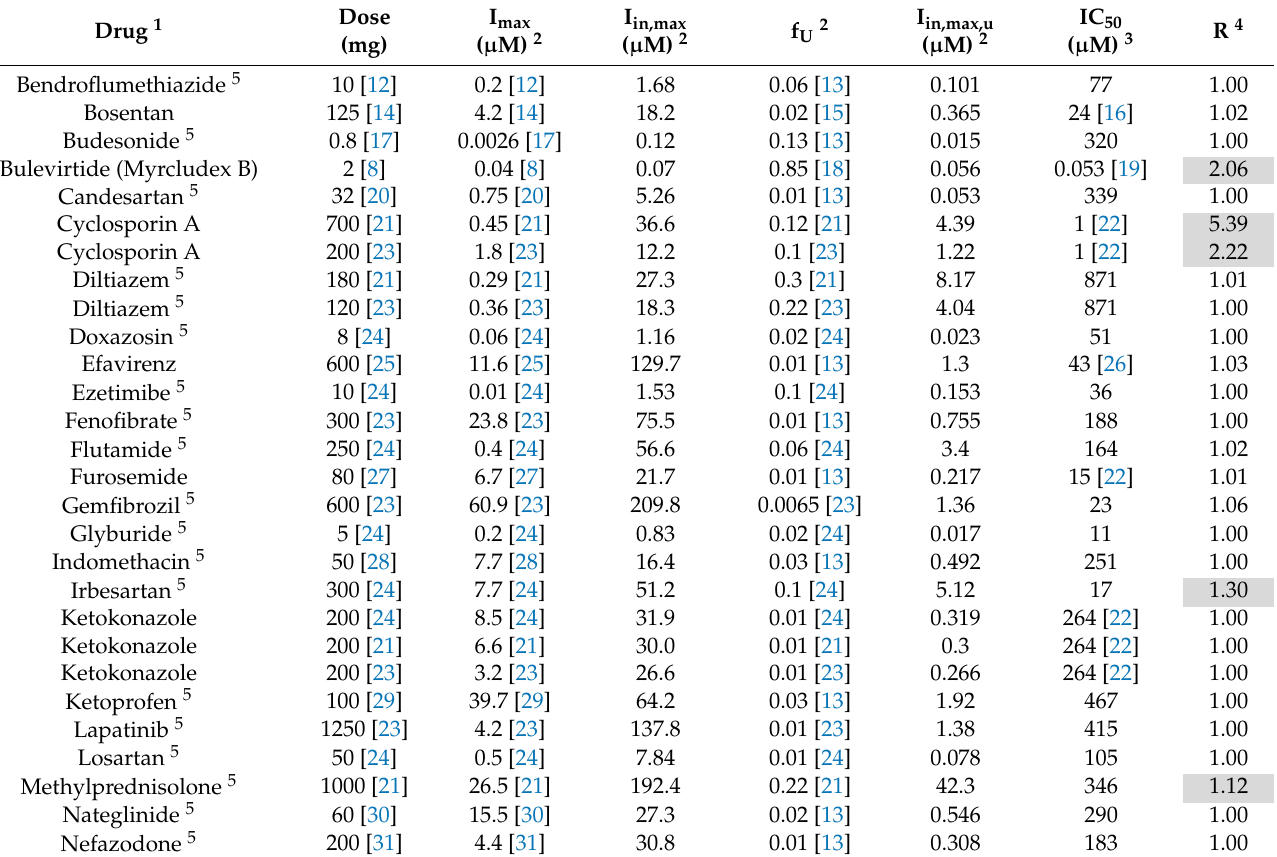
Table 1. Clinical parameters and extrapolations for NTCP inhibitor